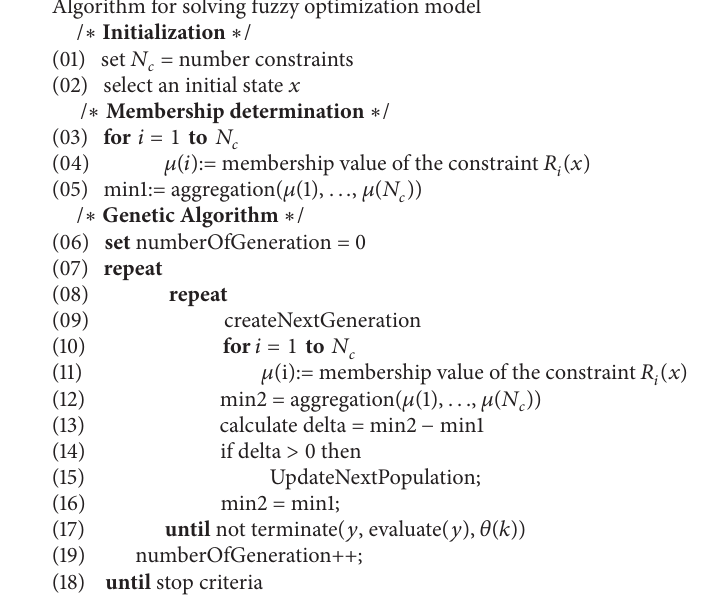
Algorithm for solving fuzzy optimization model